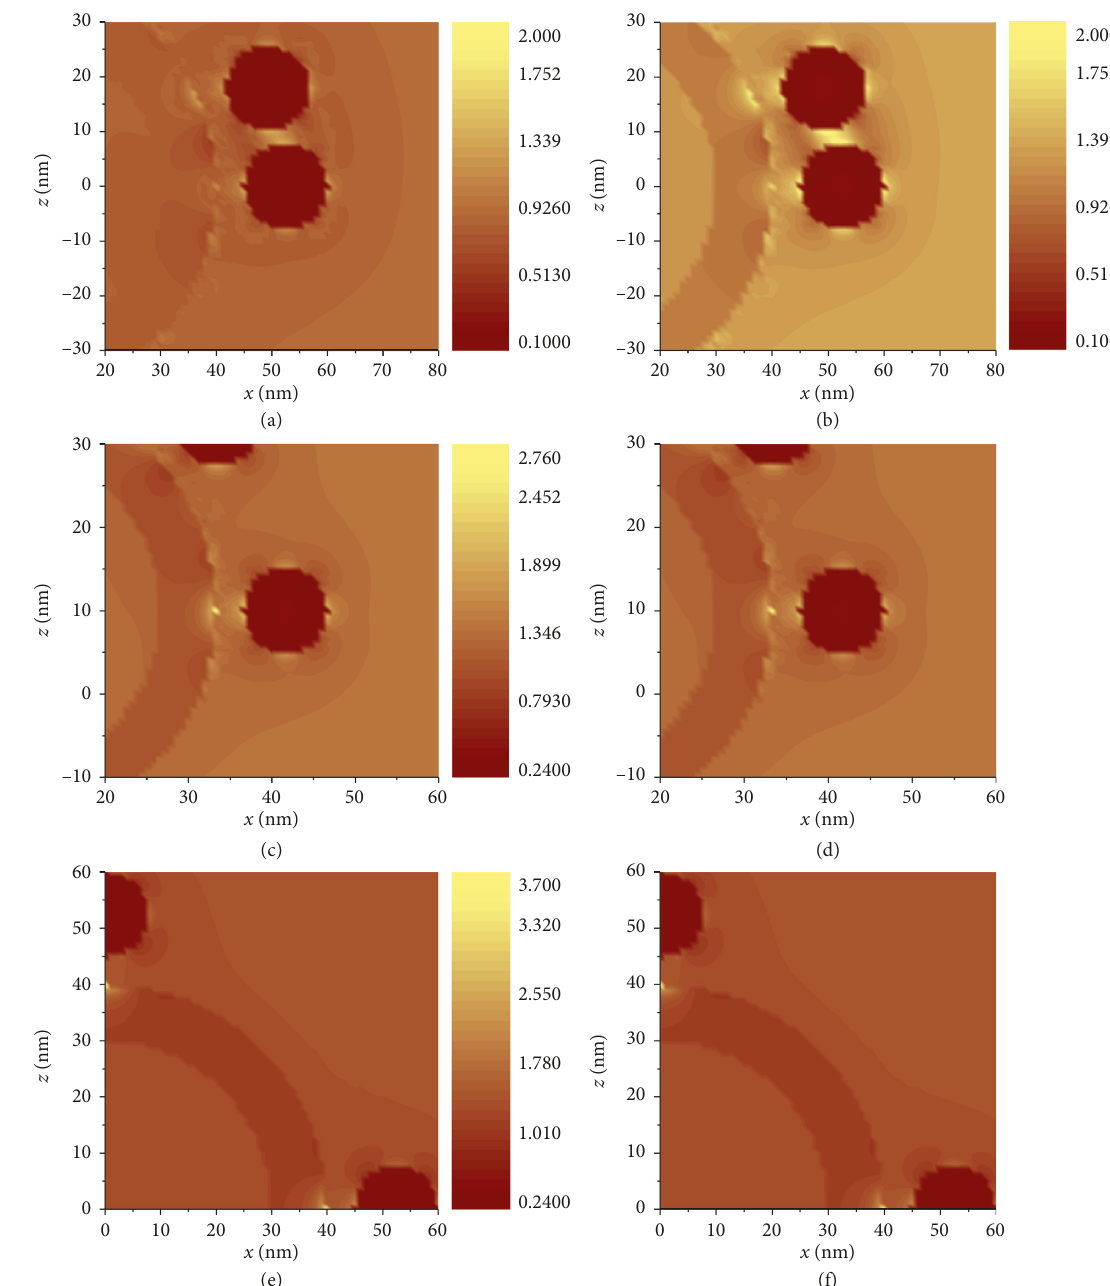
Figure 3: Local field distribution in the system of three nanoparticles in Figure 2. The big nanoparticle is of 30nm inner radius and has the shell of 10nm thickness with an inner dielectric constant value ε 5nm inner radius with 2.5nm SiO 2 shell for α � 20 ° (a, b), α � 40 ° (c, d), and α � 90 ° (e, f). (a, c, e) Taking into account the nanoparticles interaction; (b, d, f) without taking into account the nanoparticles